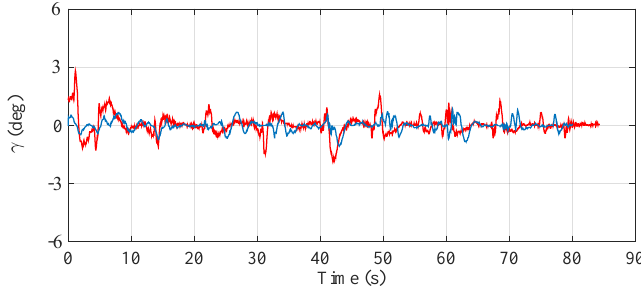
Figure 22. Inclination of the SCMS frame ( γ ) when the optimization is carried out with a α equal to 0.5 ( — ) and when the optimization is not considered ( —